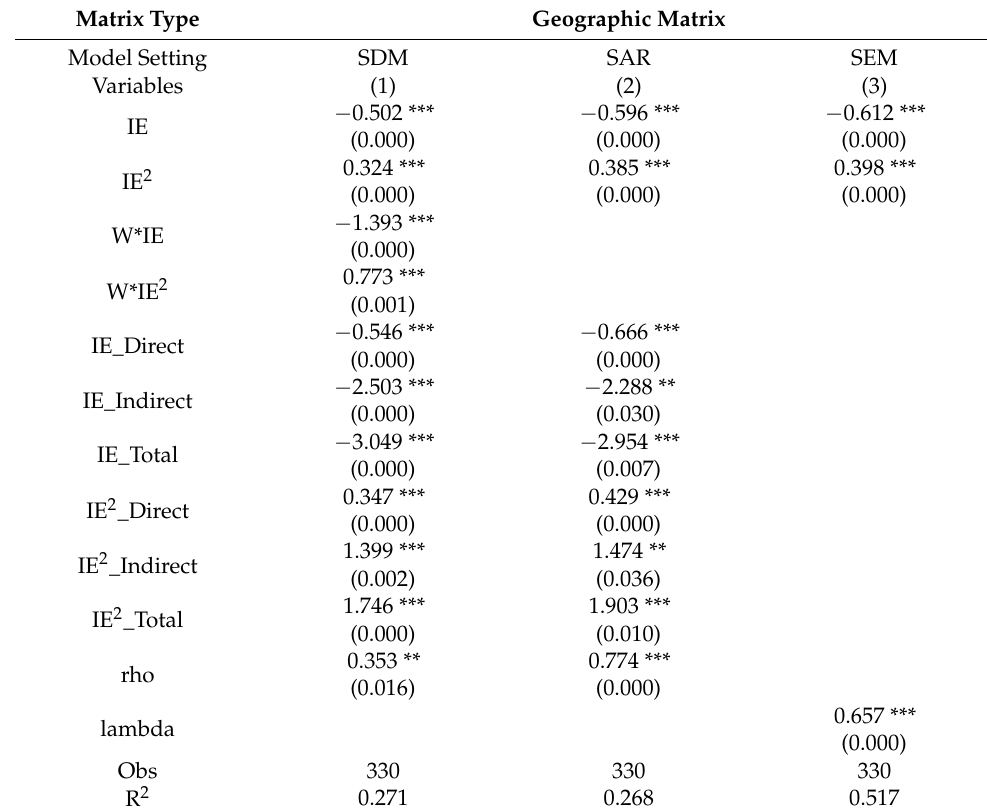
Table 5. Regression results of the spatial model.